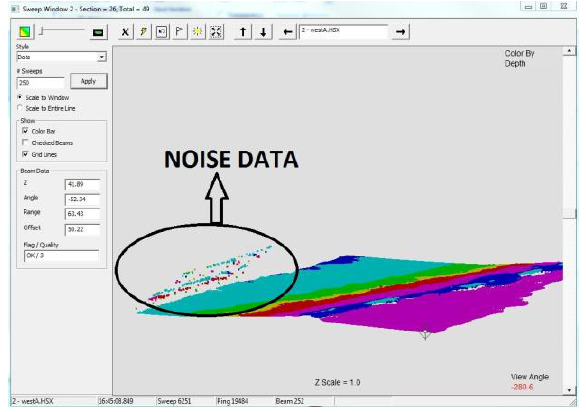
Figure 7: Noise cleaning process.